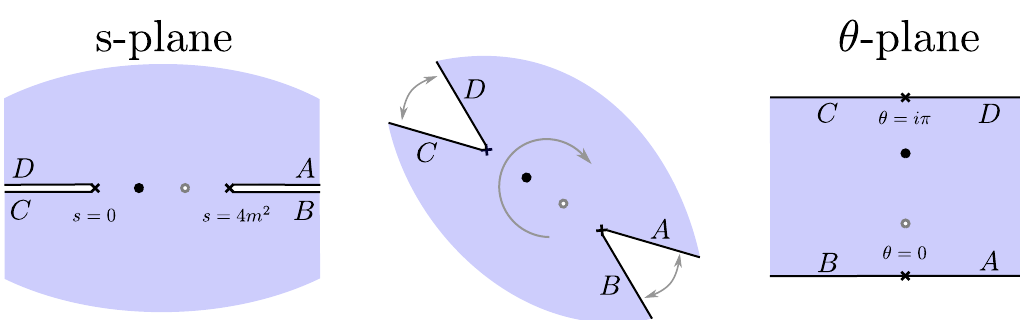
Figure 6 . Mapping from s to (cid:18) . The map \opens" the cuts and rotates clockwise by (cid:25)= 2. The physical sheet of the s-plane is mapped to the strip Im( (cid:18) ) to (cid:18) = i(cid:25) ( (cid:18) =